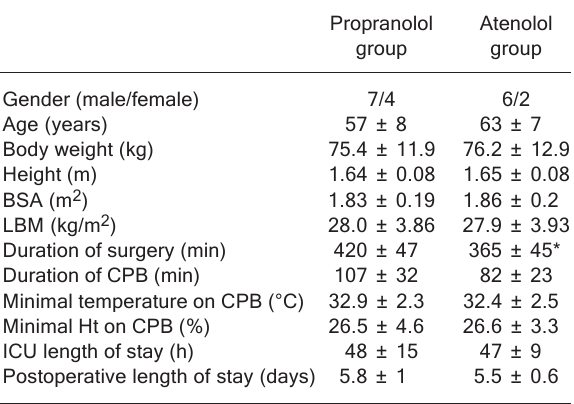
Table 1. Demographic and surgical data of the patients.